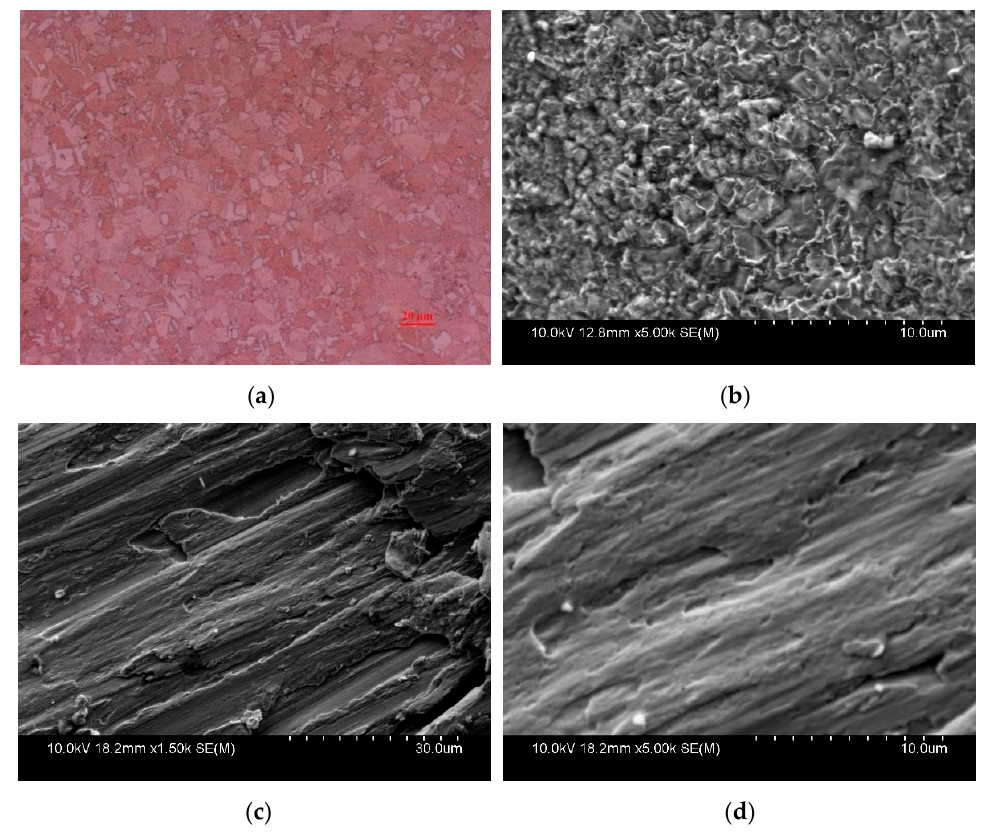
Figure 4. Comparison of microstructures in the original and recovered copper liner. ( a ) Original structure captured by metalloscope. ( b ) Original structure captured by SEM. ( c ) Fracture surface of recovered residual. ( d ) Enlarged view of fracture surface.